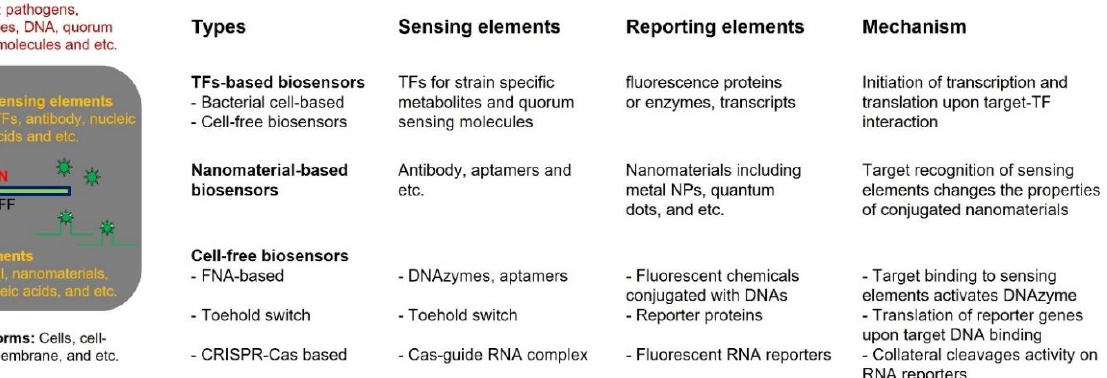
Figure 2. The components and sensing mechanisms of different biosensors for pathogen detections. nents and working mechanisms of different types of biosensors were